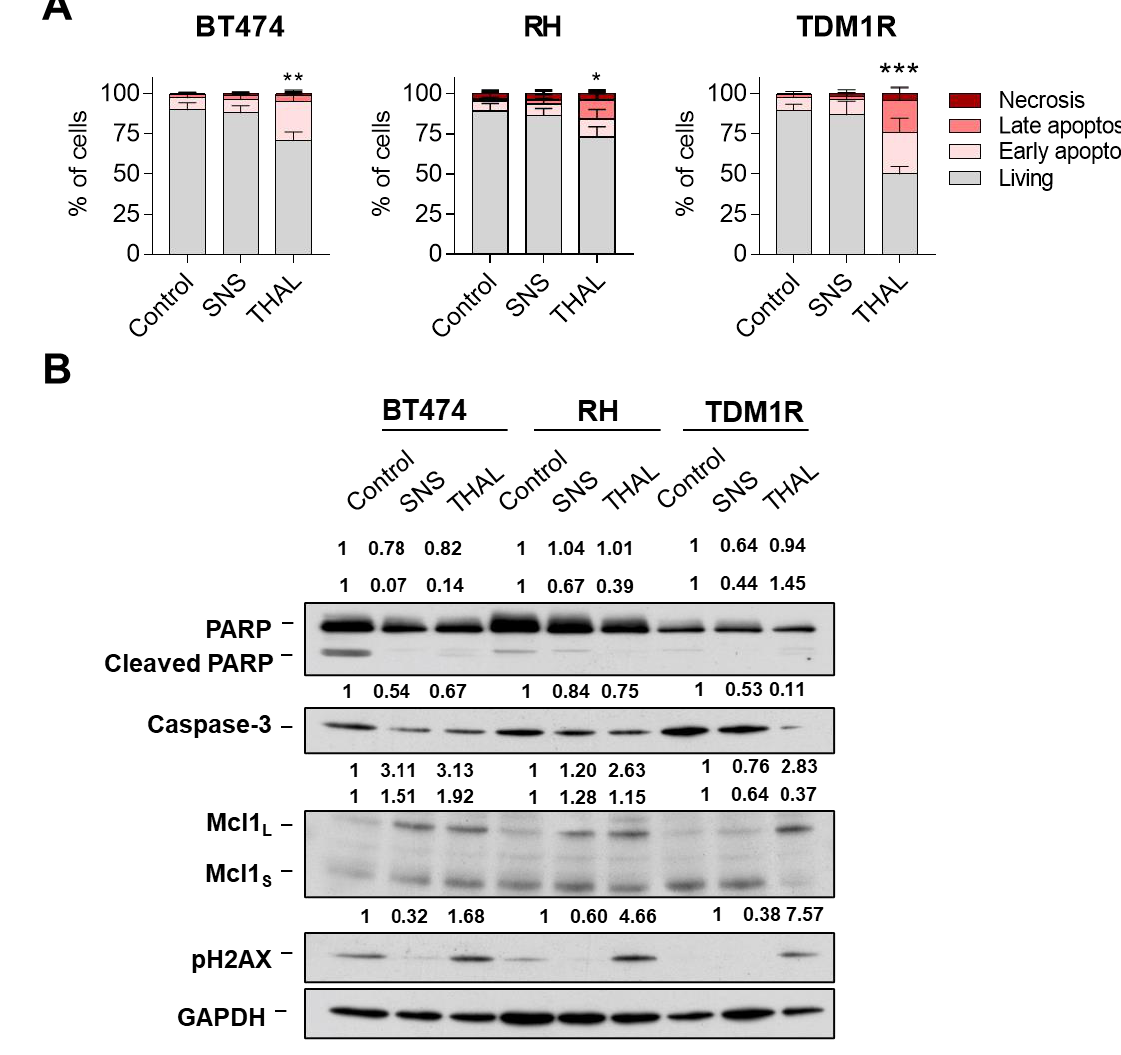
Figure 5. Apoptosis process of SNS-032 and THAL-SNS-032 in BT474 and BT474-derived cell lines representative of adaptive resistance. Cell death following SNS-032 (50 nM) or THAL-SNS-032 (50 nM) treatment after 72 h in BT474 and BT474-derived cell lines representative of adaptive resistance cell lines and resistant cell lines was evaluated by flow cytometry with annexin V and propidium iodide staining ( A ). Expression of proteins involved in cell death was evaluated by Western blot in cells lines treated at 50 nM (SNS-032 and THAL-SNS-032) for 72 h. GAPDH was used as a loading control ( B ). * p < 0.05; ** p < 0.01; *** p < 0.001.